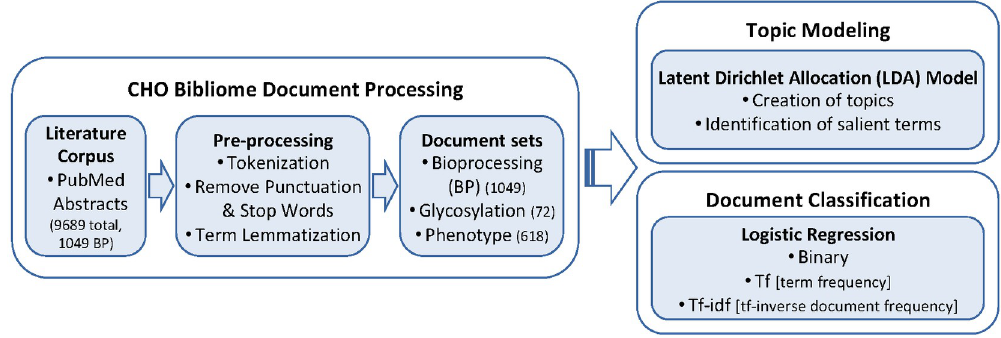
Fig 1. Overview of the CHO bibliome processing and analysis